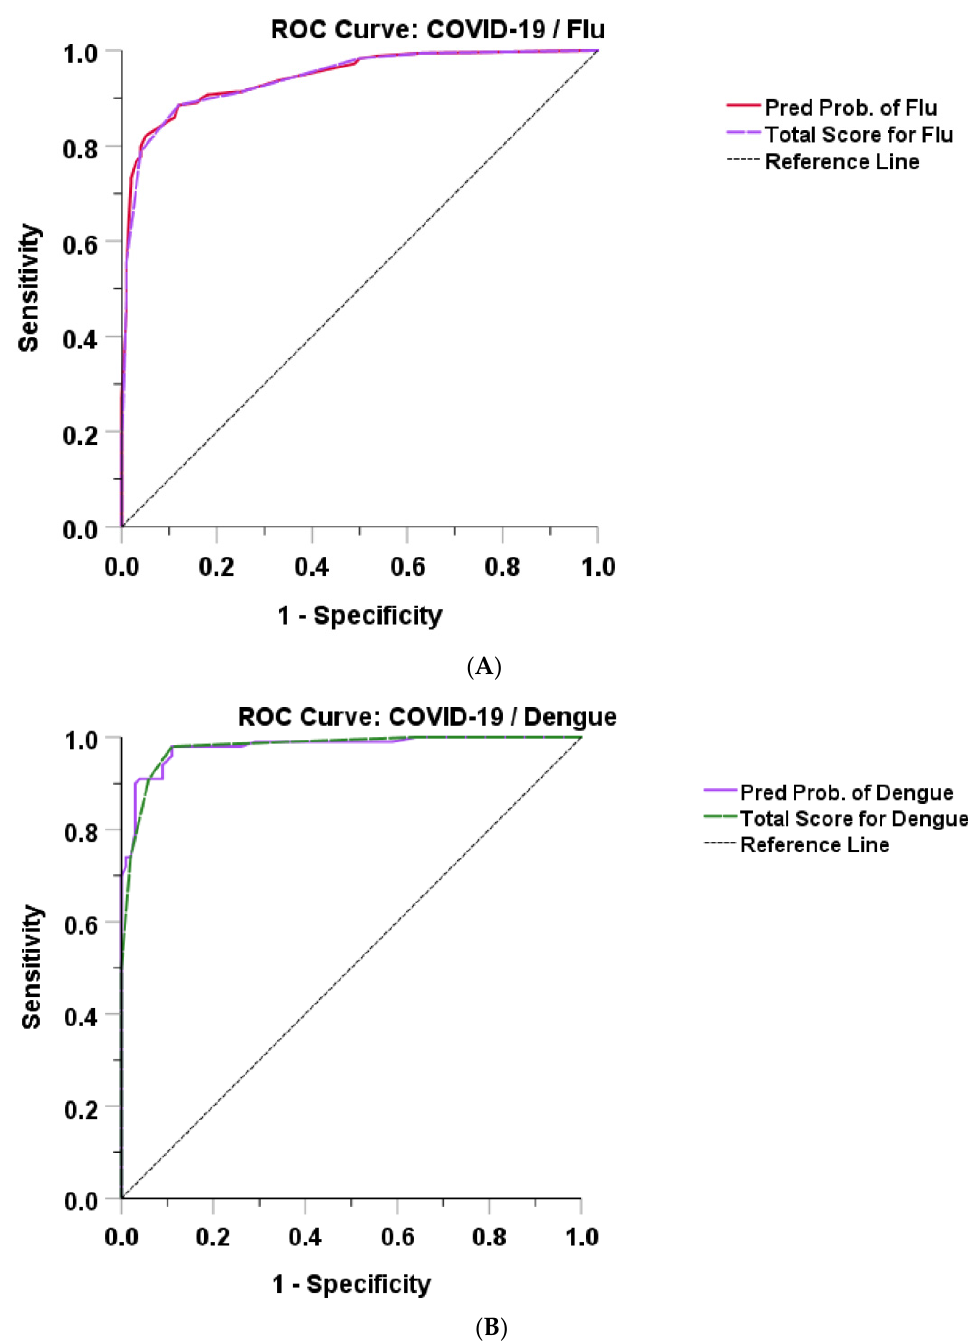
Figure 2. Receiver operating characteristic ( ROC ) curves of predicted probability and total score for ( A ) influenza or RSV and ( B ) dengue . Table 7. Accuracy of total score for influenza / RSV and dengue.